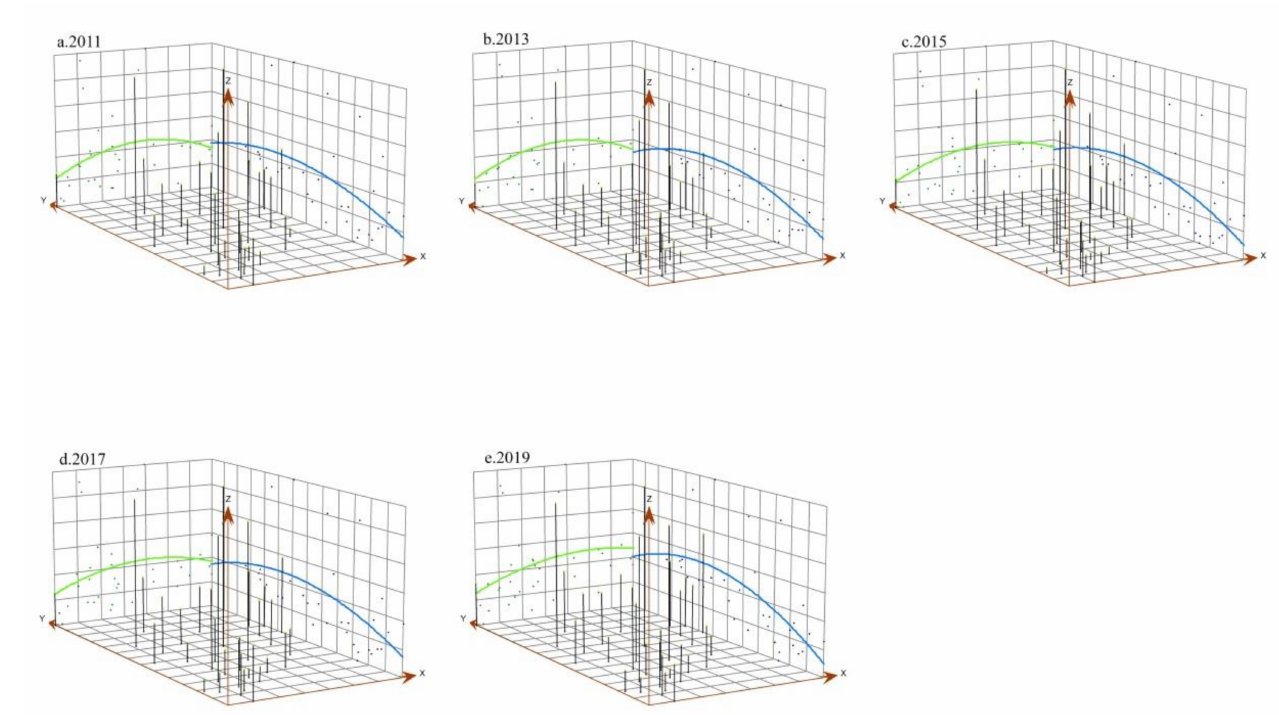
Figure 8. The trend surface analysis of urban PHSs and RHSs in northeast China in